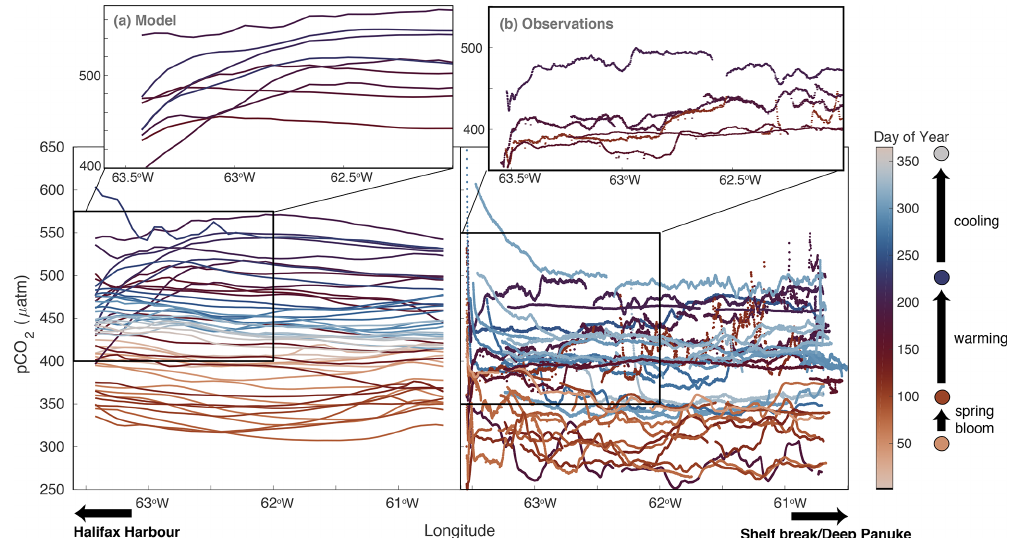
Figure 4. Temporal evolution of p CO 2 across the Atlantic Condor transect. The x axis is longitude, with the Halifax Harbour indicated on the left-hand side and the shelf break indicated on the right-hand side of each panel; the y axis is p CO 2 ; and the colour indicates the day of the year. The left panel is year 2006 of the model along the transect every 7d. The right panel shows all of the observations along the transect. The upper insets zoom in on the indicated boxes showing only the events with lower p CO 2 near shore in the summer months (dark red/purple coloured